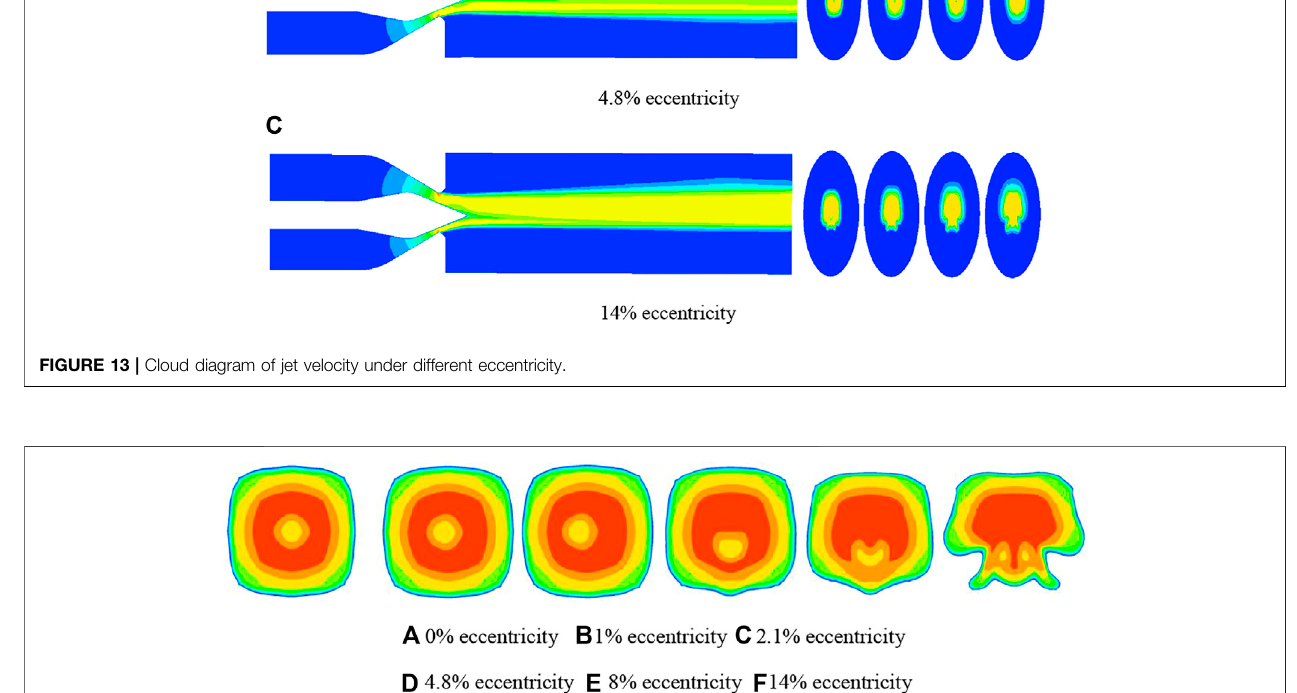
Frontiers in Energy Research |